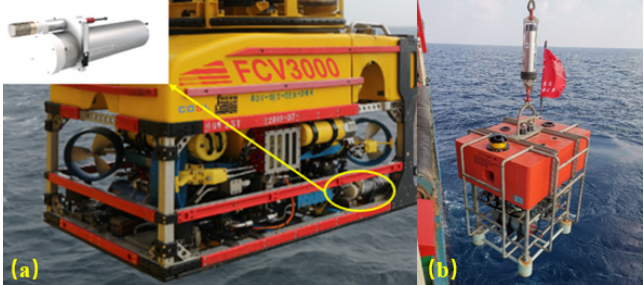
Figure 1. Subsea boundary layer methane monitoring methods: ( a ) ROV with methane sensor and ( b ) subsea submersible observing system. ( b ) subsea submersible observing